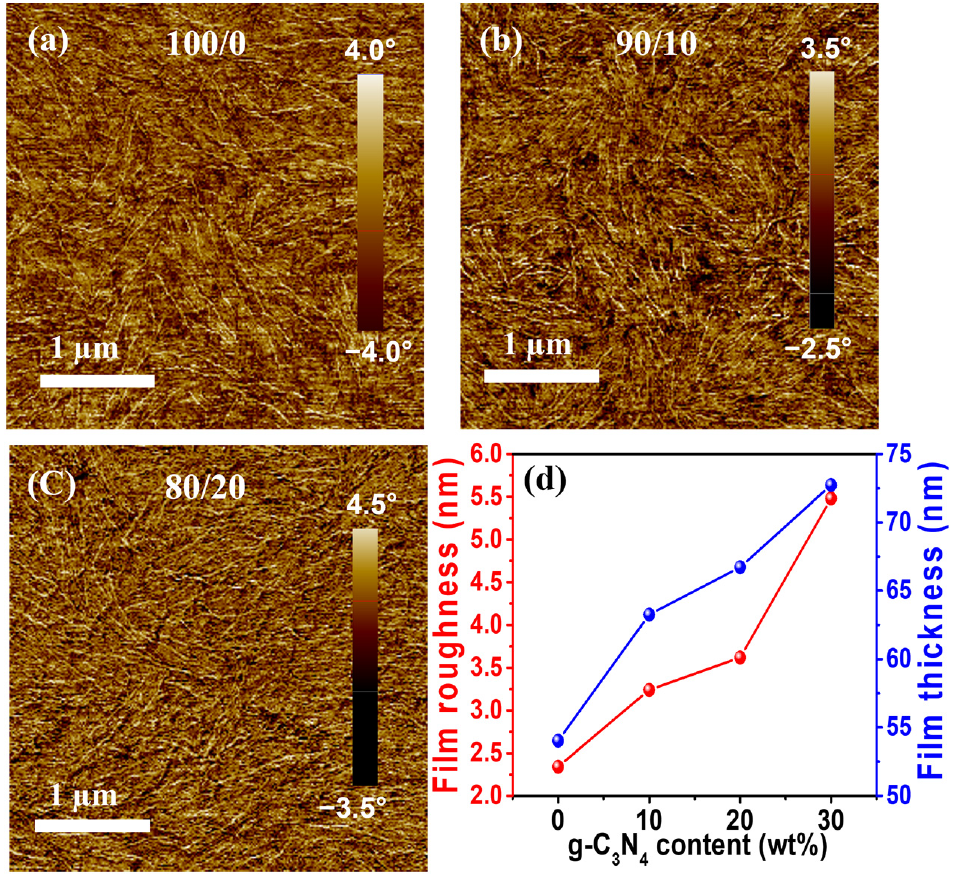
Figure 3. AFM images of ( a ) bare P3HT (100/0), ( b ) P3HT/g-C ₃ N ₄ (90/10), and ( c ) P3HT/g-C ₃ N ₄ (80/20) composite films. ( d ) Thickness and roughness of P3HT/g-C ₃ N ₄ composite films with different g-C ₃ N ₄ contents (0, 10, 20, and 30 wt.%).